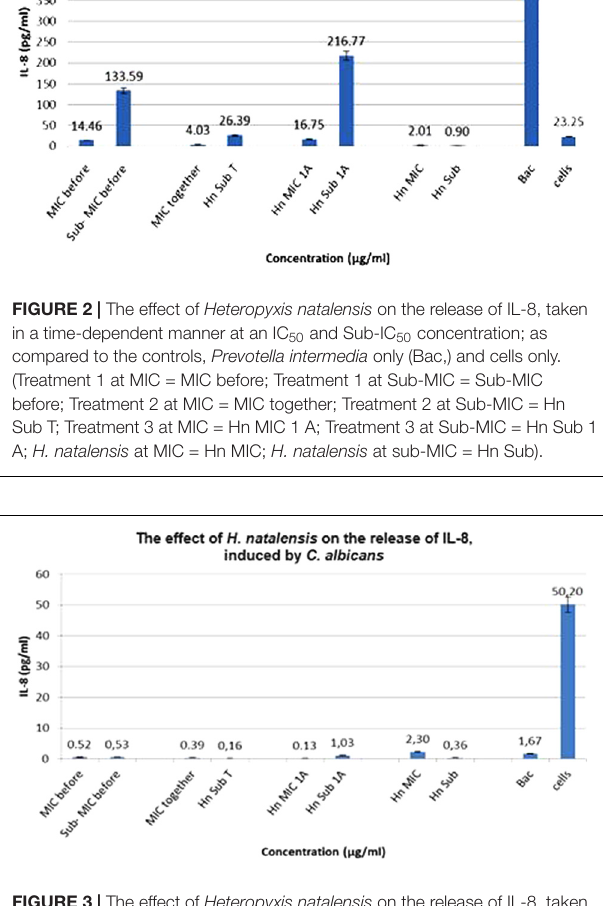
FIGURE 3 | The effect of Heteropyxis natalensis on the release of IL-8, taken in a time-dependent manner at an IC 50 and Sub-IC 50 concentration; as compared to the controls, Candida albicans only (Bac) and cells only. (Treatment 1 at MIC = MIC before; Treatment 1 at Sub-MIC = Sub-MIC before; Treatment 2 at MIC = MIC together; Treatment 2 at Sub-MIC = Hn Sub T; Treatment 3 at MIC = Hn MIC 1 A; Treatment 3 at Sub-MIC = Hn Sub 1 A; H. natalensis at MIC = Hn MIC; H. natalensis at sub-MIC = Hn Sub).